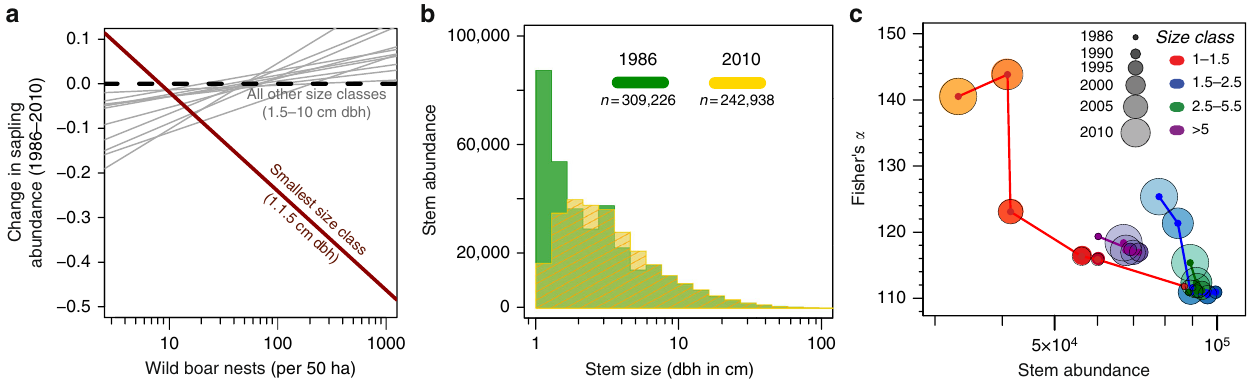
Fig. 4 Changes in forest tree composition in the 50-ha research plot from 1986 to 2010. a Relationship between relative change in abundance of 12 sapling size classes over the fi ve census intervals during which time wild boar nest abundance varied by two orders of magnitude. Gray lines show no signi fi cant relationship between wild boar and sapling abundance for twelve sapling size classes (binned by 0.5-cm dbh breaks for stems 1 – 4 cm dbh and binned by 1-cm breaks for stems 4 – 10 cm dbh). Red line shows the relationships for the smallest size class (1 – 1.5 cm dbh; F 7,39 = 14.78, R 2 (adj) = 0.677, P < 0.001). The thick dotted black line indicates no change (null hypothesis). b Tree-size distribution shift from 1986 (green) to 2010 (yellow) for all stems within the 50-ha FDP (KS, d = 0.26109, P < 0.001). c Diversity shifts by size class for each FDP census ( n = 435,591 stems for all censuses